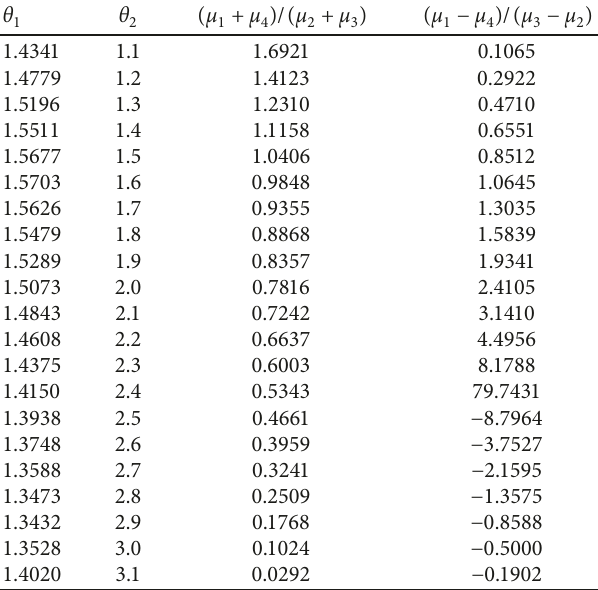
Table 2: Some numerical results of θ ( μ